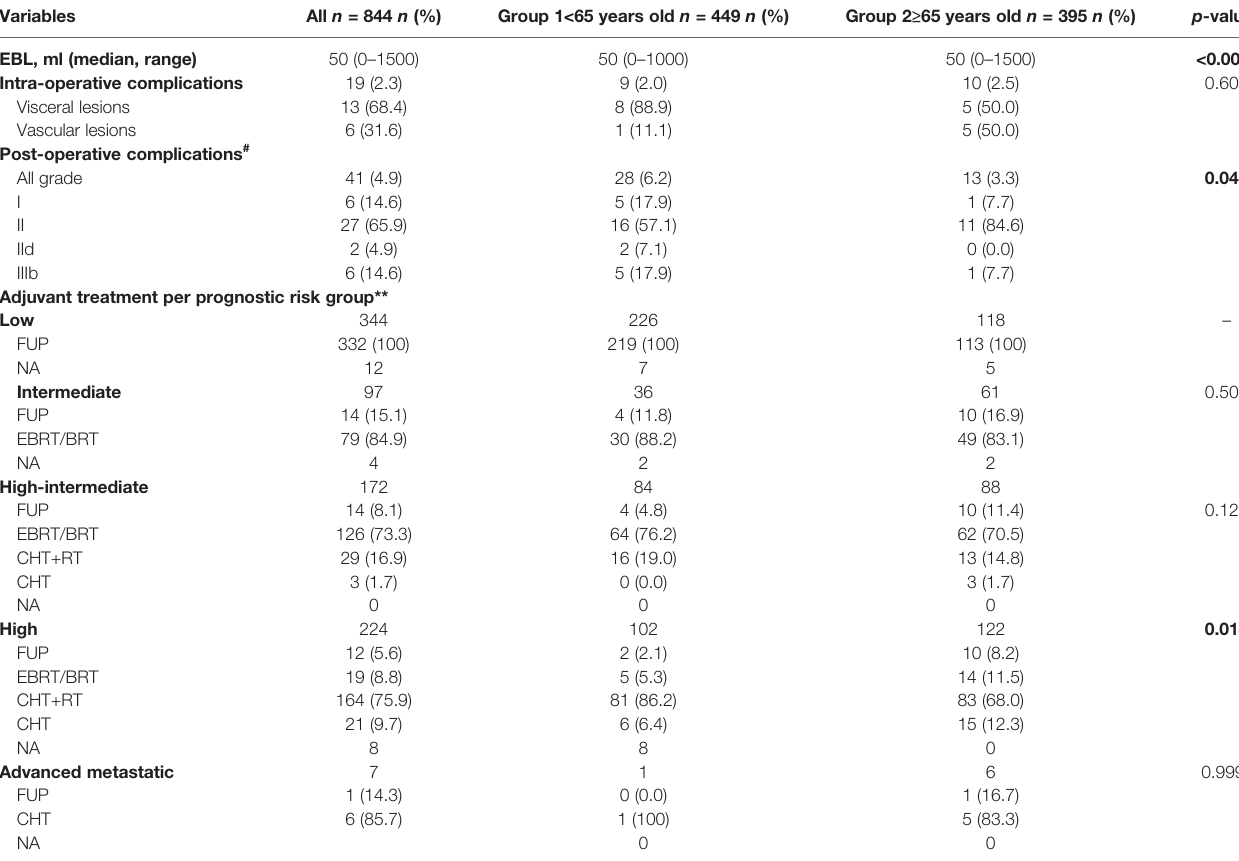
TABLE 5 | Intraoperative complications, postoperative complications, and adjuvant treatment of the enrolled population.